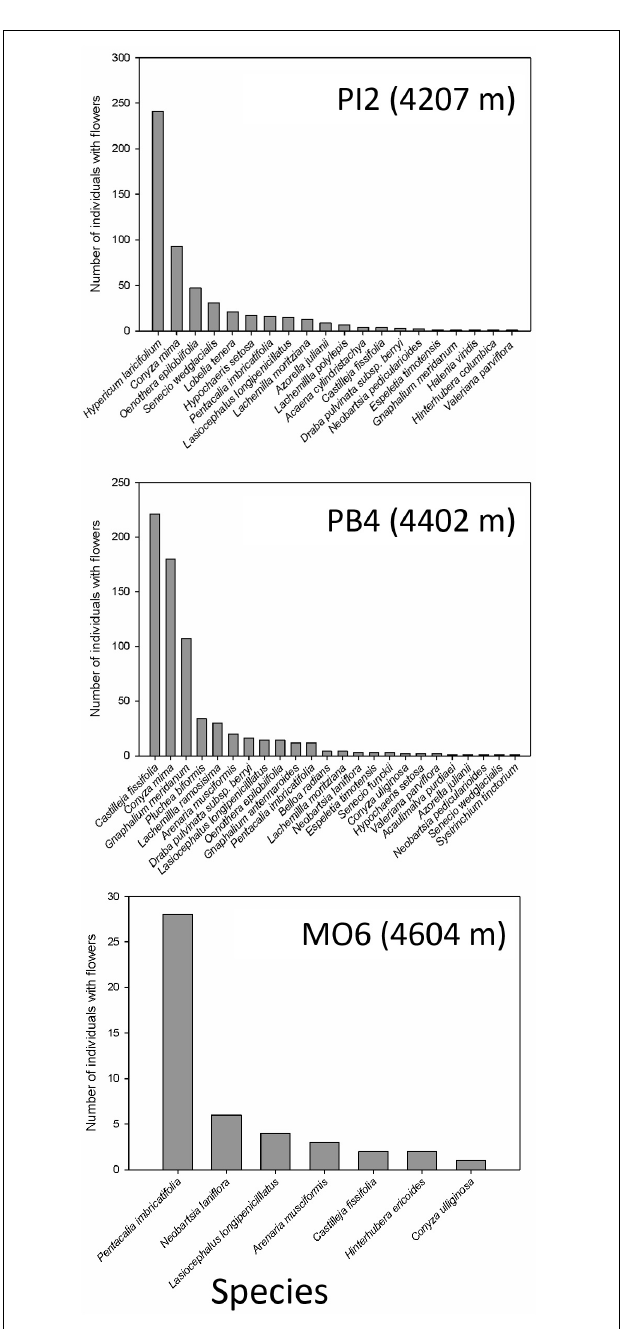
FIGURE 3 | Total number of recorded individuals with flowers per species in the four 3 × 3 m permanent plots (36 m 2 ) during 1 year, in each summit of the GLORIA–Andes network (VE-CPB site), at La Culata National Park, Piedras Blancas Páramo, Venezuela.